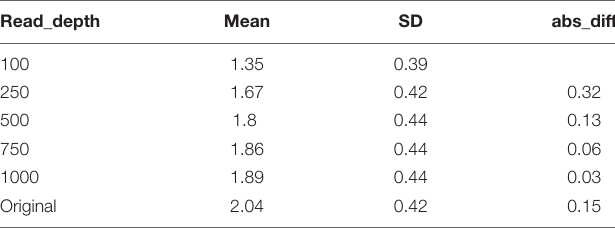
TABLE 2 | Average Shannon index values among children less than 15 months at different subsampling depths in the RESONANCE